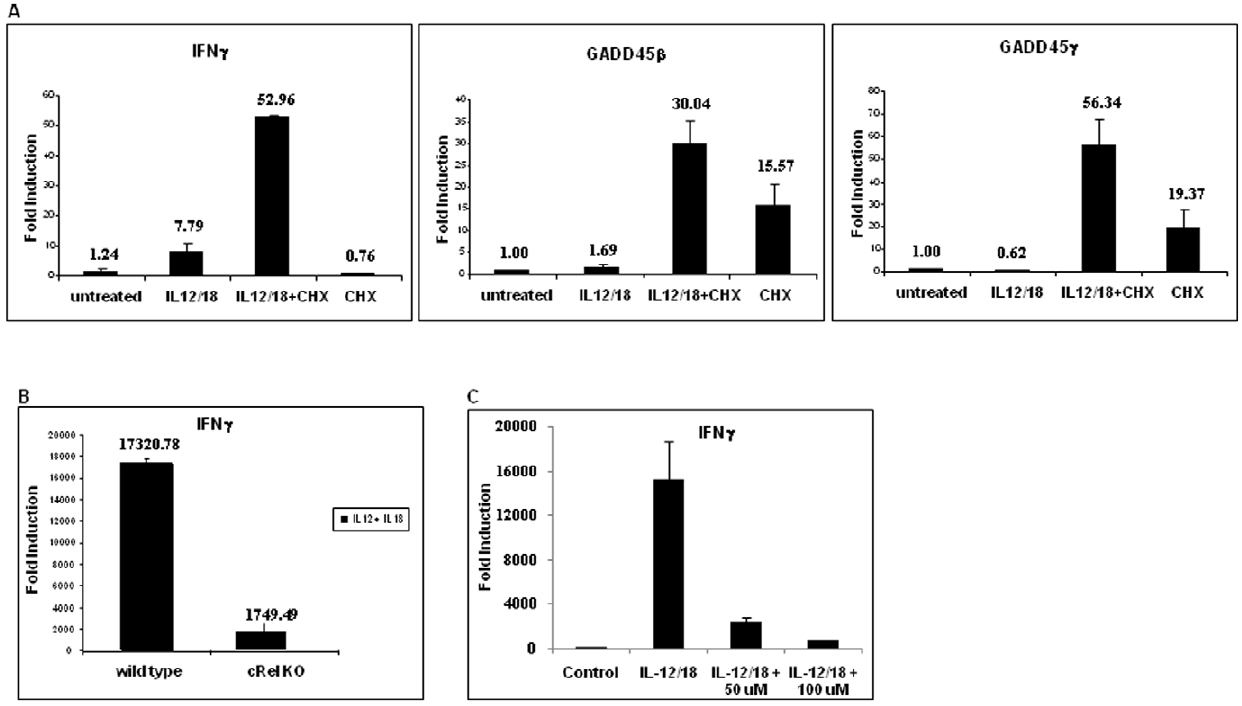
Figure 4. Effect of cytokine treatment on the mRNA levels of IFN- c , GADD45 b and GADD45- c . (A) Human peripheral blood CD4 + T cells were pre-treated with cyclohexamide (10 m g/ml) for 30 minutes followed by stimulation with IL-12 and IL-18 for 4 hours. Total RNAs were isolated and analyzed by real-time PCR. The quantity of each cDNA was normalized by GAPDH. Data represent average 6 SD from triplicate. (B) Role of cRel in cytokine signaling. Splenic CD4 + T cells from wild type and cRel knockout mice were activated with IL-12 plus IL-18 for 24 hours and the IFN- c mRNA levels were determined by real-time PCR. The quantity of each cDNA was normalized by GAPDH. Data represent average 6 SD from triplicate. (C) Role of NF k B/Rel family transcription factors in cytokine signaling in human CD4 + T cells. Human CD4 + T cells were pretreated with IKK-2 inhibitor (50 and 100 m M) for 1 hour before activating the cells with IL-12 plus IL-18 for 18 hours. IFN- c mRNA levels were then determined by real-time PCR. The quantity of each cDNA was normalized by